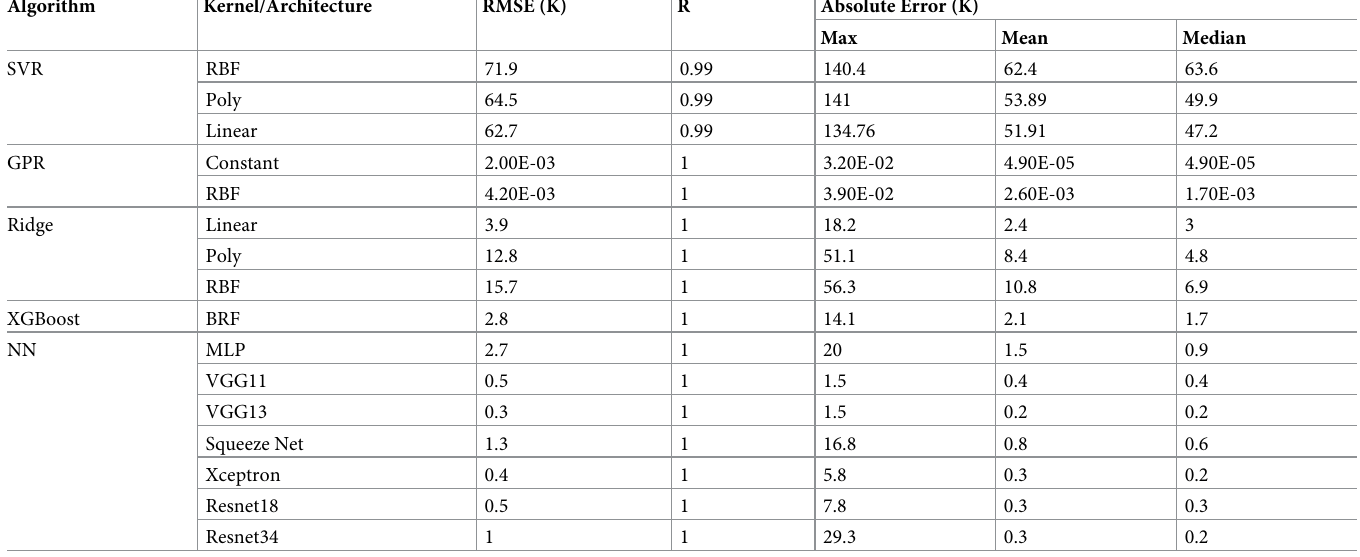
Table 2. Machine learning model performance on uniform-profile spectra.